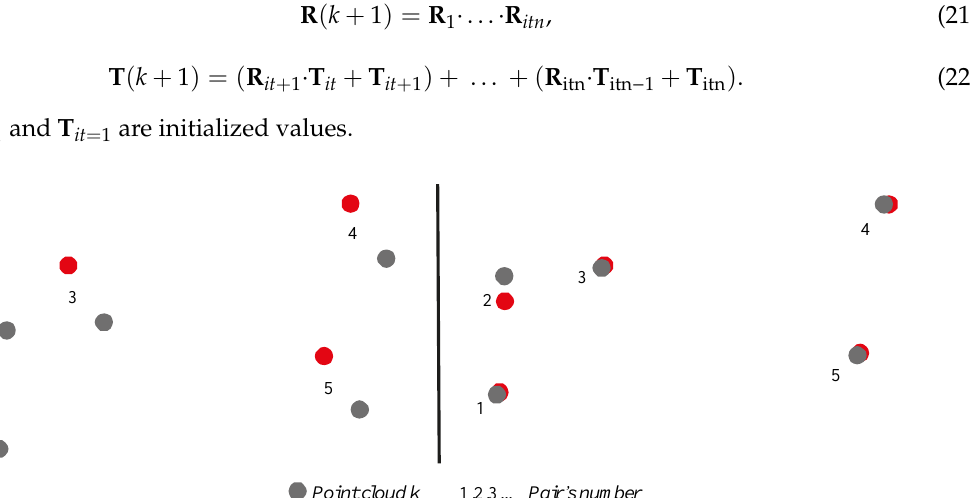
Figure 6. Left side — 2-point clouds; right side — 2-point clouds aligned. Figure 6. Left side—2-point clouds; right side—2-point clouds